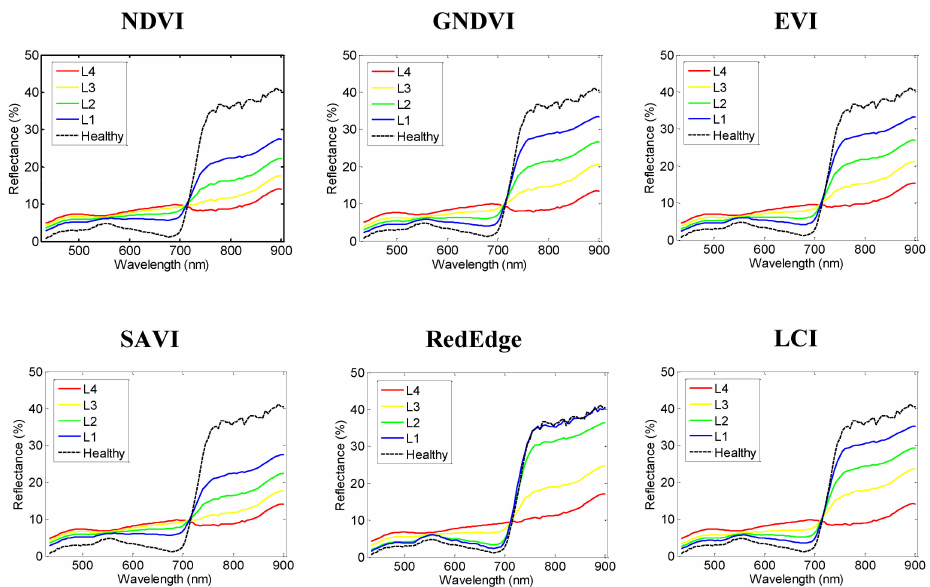
Figure 9. Average spectra of di ff erent severity levels of cotton root rot in Field B.